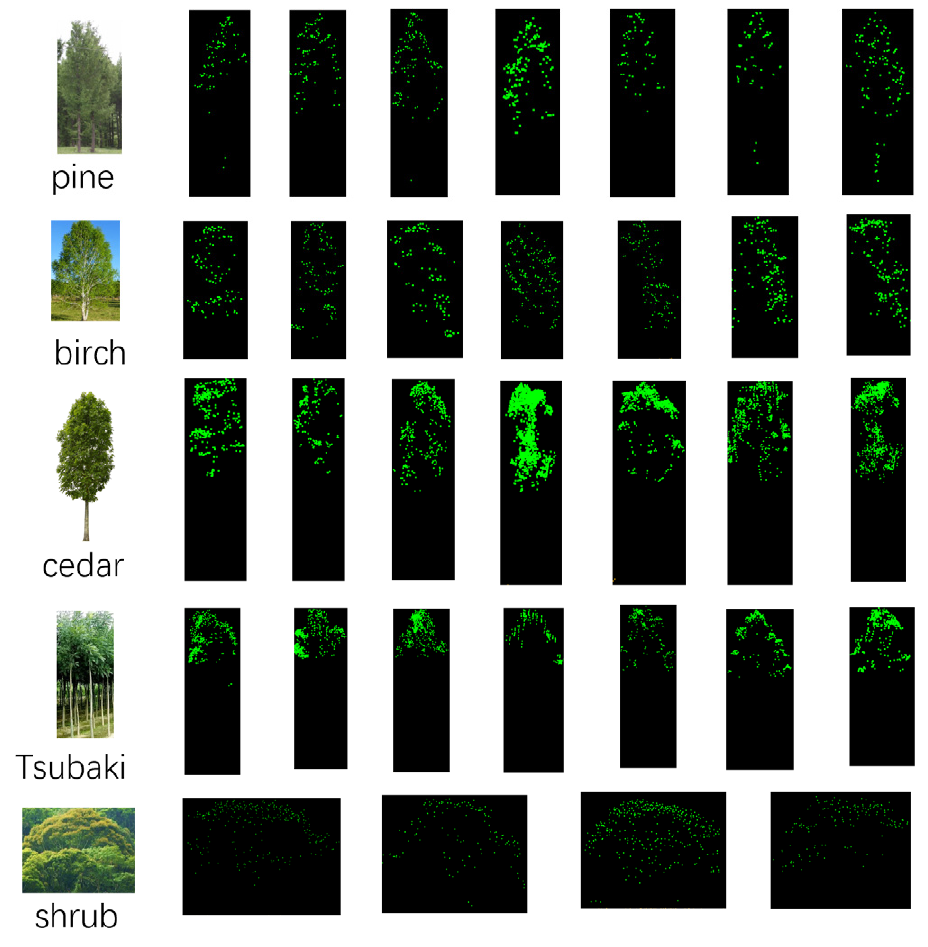
Figure 9. Various tree species with different profile structures.